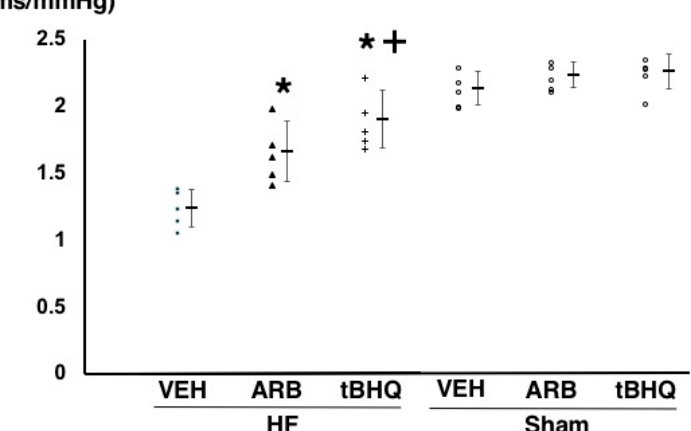
Figure 5. Baroreflex sensitivity of heart failure treated with intracerebroventricular (ICV) infusion of vehicle (HF-VEH), or with ICV infusion of angiotensin II type 1 receptor blocker (HF-ARB), or with ICV infusion of nuclear factor erythroid 2-related factor 2 activator, tert -butylhydroquinone (HF-tBHQ), or sham treated with ICV infusion of VEH, or with ICV infusion of ARB, or with ICV infusion of tBHQ. n = 5 for each group. All data are shown in dot plot and mean ± standard deviation. * p < 0.05 vs. HF-VEH in HF-ARB and HF-tBHQ. + p < 0.05 vs. HF-ARB in HF-tBHQ.